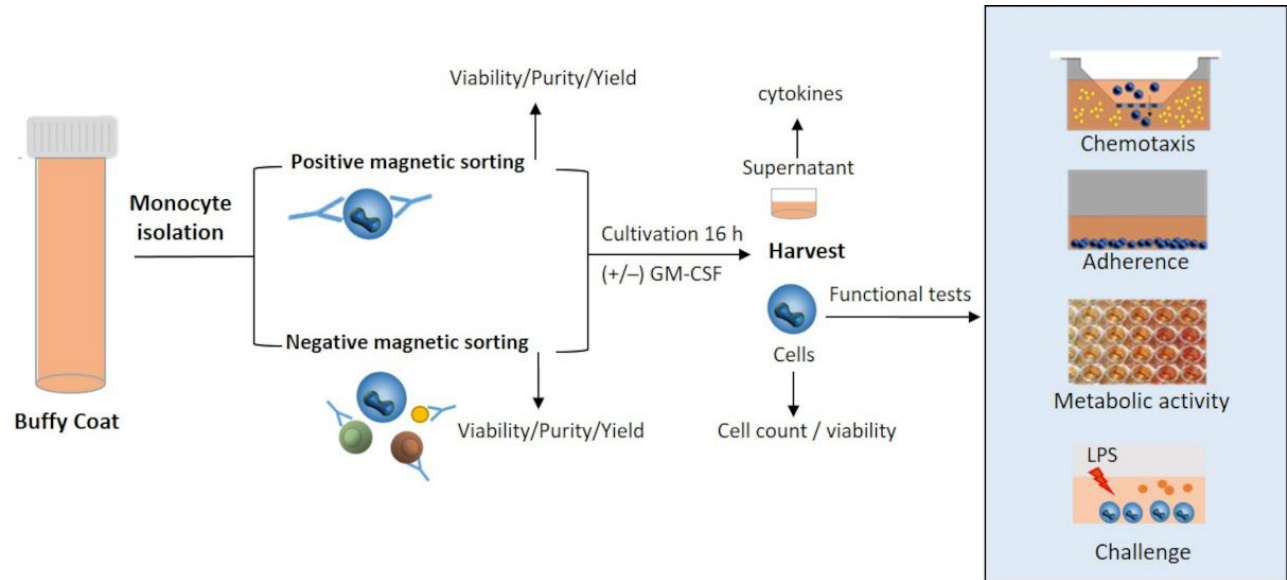
Figure 1. Experimental design. Monocytes were isolated from human BCs either via positive or negative magnetic sorting. Subsequently, the monocytes were cultivated ex vivo with or without GM-CSF. After 16 h, cells and supernatants were harvested for assessment. Abbr.: GM-CSF, granulocyte-macrophage colony-stimulating factor; LPS, lipopolysaccharides.